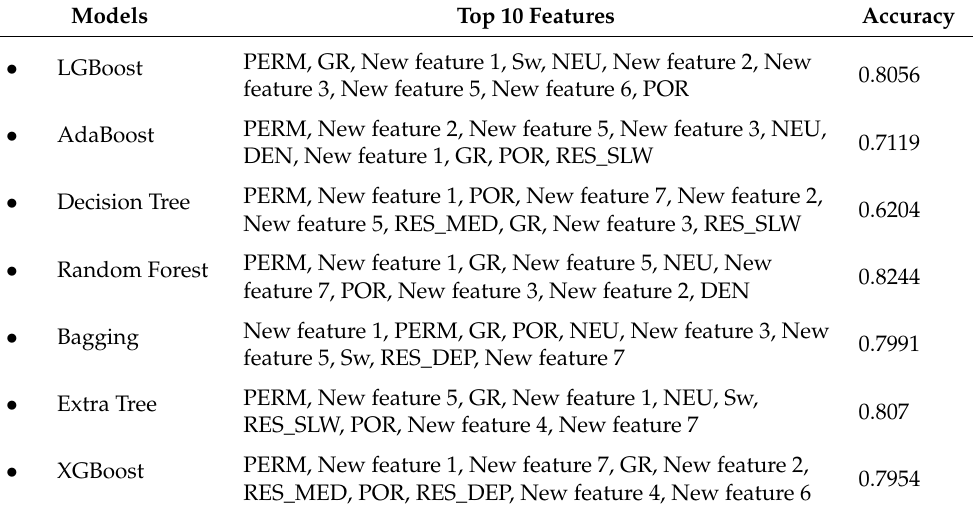
Table 7. Computed feature importance and accuracy on test data using different models.